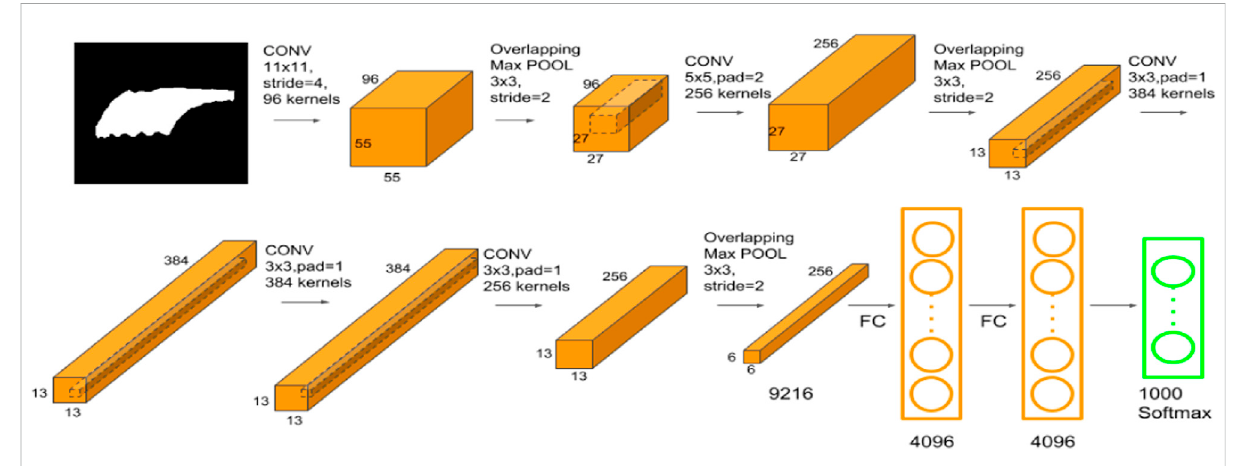
FIGURE 1 AlexNet network